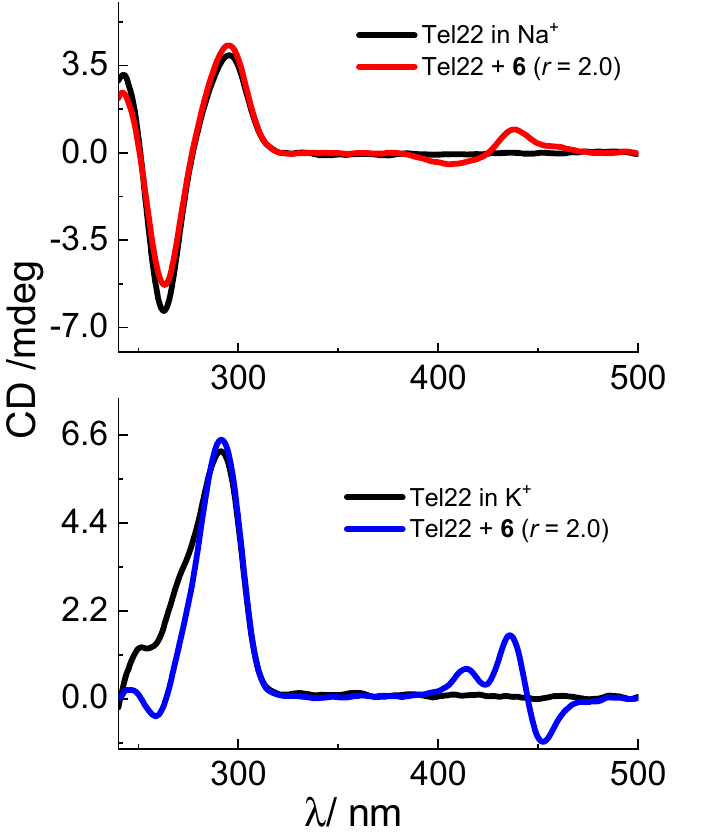
Figure 5. CD spectra of Tel22 ( c = 1.5 × 10 − 6 mol dm − 3 ) with dye 6 at molar ratios r = [compound]/[nucleotide phosphate] = 2.0 (pH = 7.0, I = 0.1 mol dm − 3 , buffer sodium cacodylate or potassium phosphate.